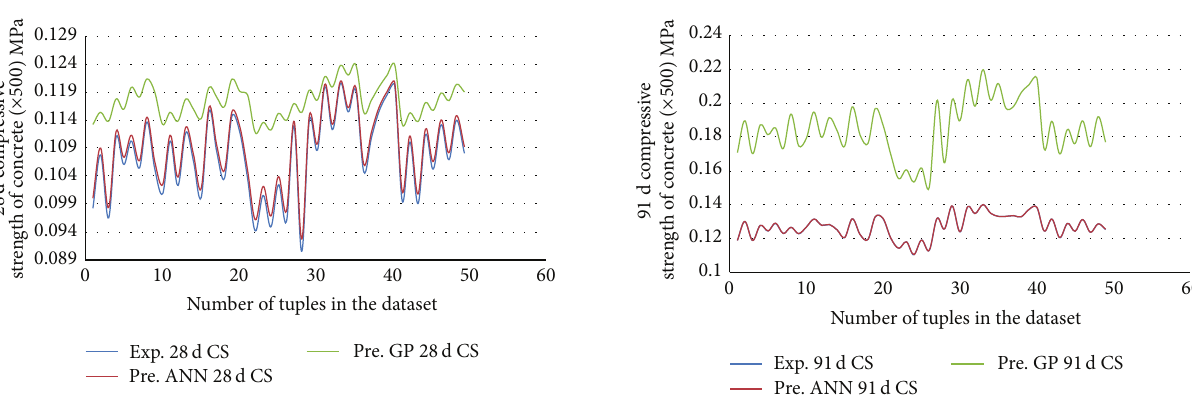
Figure 3: Comparison between actual and predicted values of 91d compressive strength of concrete.